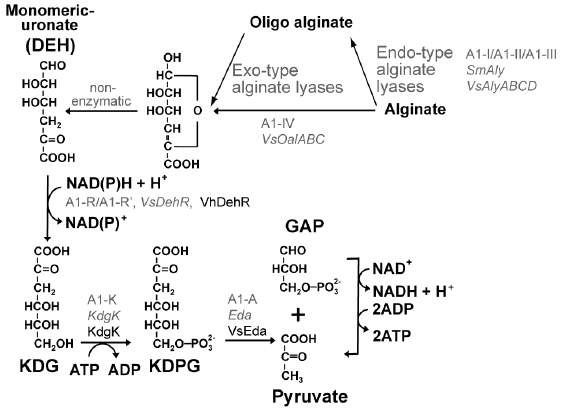
Figure 2. Alginate metabolism. Enzymes present in Sphingomonas sp. A1 [31,36,37] are in roman gray; those present or introduced in bioengineered E. coli [18] are shown in gray italics; and those introduced in bioengineered S. cerevisiae [20] are shown in black. The bioengineered S. cerevisiae assimilates 4-deoxy- L -erythro-5-hexoseulose uronate (DEH), but not alginate [20]. Details are described in the text. KDG: 2-keto-3-deoxy- D -gluconate; KDPG: 2-keto-3-deoxy-phosphogluconate; GAP: glyceraldehyde-3-phosphate; VhDehR: V. harveyi DehR; VsOalABC: V. splendidus 12B01 OalABC; SmAly: Pseudoalteromonas sp. SM0524 Aly; VsSlyABCD: V. splendidus 12B01 SlyABCD; VsEda: V. splendidus 12B01 Eda. Protein Table 4. K m and K cat or V max of 4-deoxy- L -erythro-5-hexoseulose uronate (DEH) reductases.